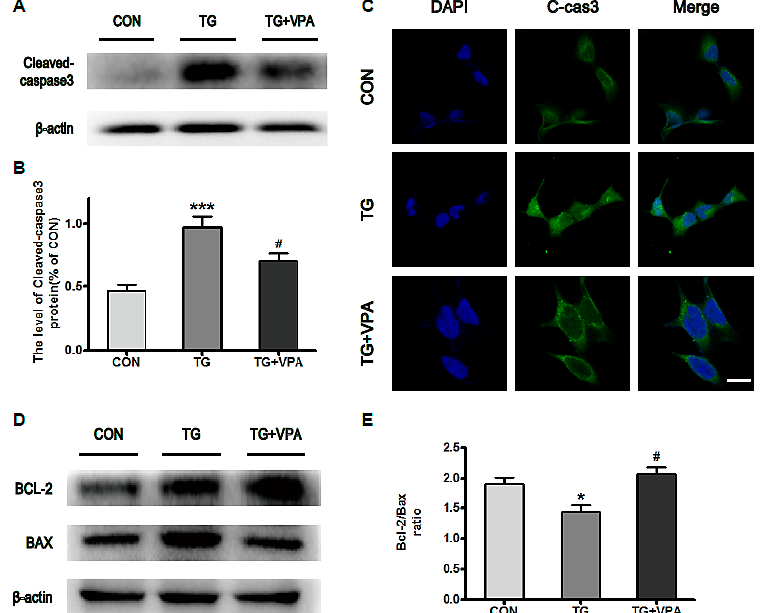
Figure 5. VPA reduces the level of cleaved caspase-3 and increases the ratio of Bcl-2/BAX in SH-SY5Y cells. ( A , B ) The expression of cleaved caspase-3 in the three groups was investigated by Western blot analysis and immunofluorescence assay. # p < 0.05 versus the TG group; *** p < 0.001 versus the control group; ( C ) Immunofluorescence of cleaved-caspase-3 (green); the nuclear (blue) was labelled with DAPI. Magnification was 40×; ( D ) Protein levels of Bcl-2 and Bax; ( E ) The ratio of Bcl-2/Bax. * p < 0.05 versus the control group. # p < 0.05 versus the TG group ( t -test). Data are the mean values ± SEM, n = 4.